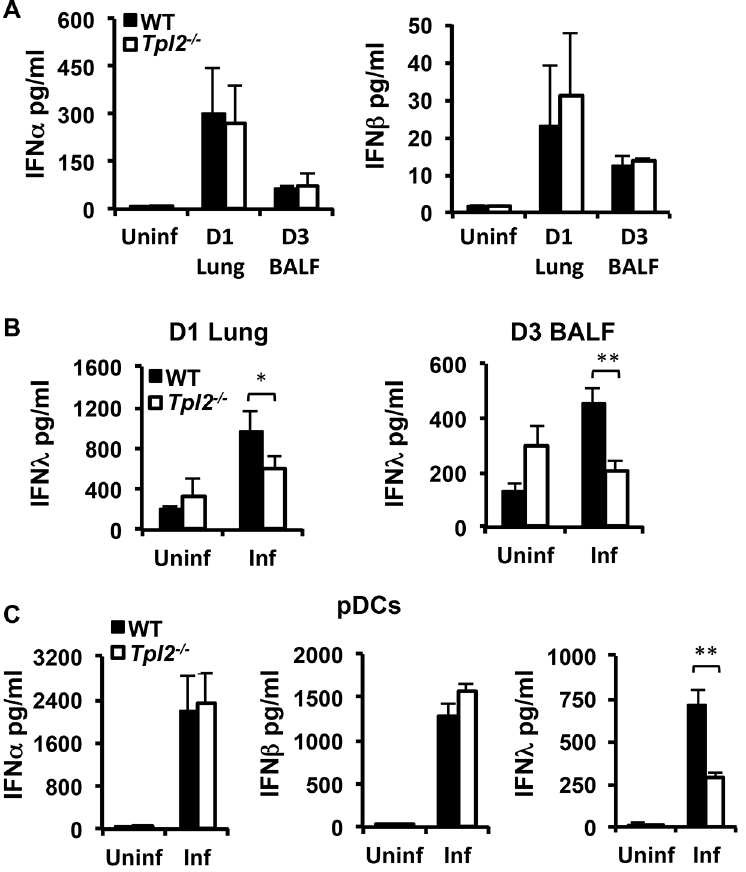
Fig 2. Tpl2 is required for optimal IFN λ production during influenza virus infection in vitro and in vivo . WT and Tpl2 -/- mice were infected with 10 6 pfu of X31 virus, and IFN α , β (A) , and λ (B) levels in D1 lung homogenates or D3 BALF were measured by ELISA or bead based assay. For IFN α , n = 4 uninfected and 7 infected mice per group; for IFN β , n = 2 uninfected and 3 infected per group; for D1 IFN λ n = 5 (WT) and 6 ( Tpl2 -/- ) uninfected and 10 (WT) and 12 ( Tpl2 -/- ) infected; for D3 IFN λ n = 5 uninfected and 14 infected (WT) and 13 ( Tpl2 -/- ) infected. (C) pDCs from WT and Tpl2 -/- mice were infected with WSN virus at an MOI of 0.2 for 24 hr, and IFN α , β and λ levels were measured. Data are representative of 3 – 4 independent experiments. * indicates p < 0.05, ** indicates p <